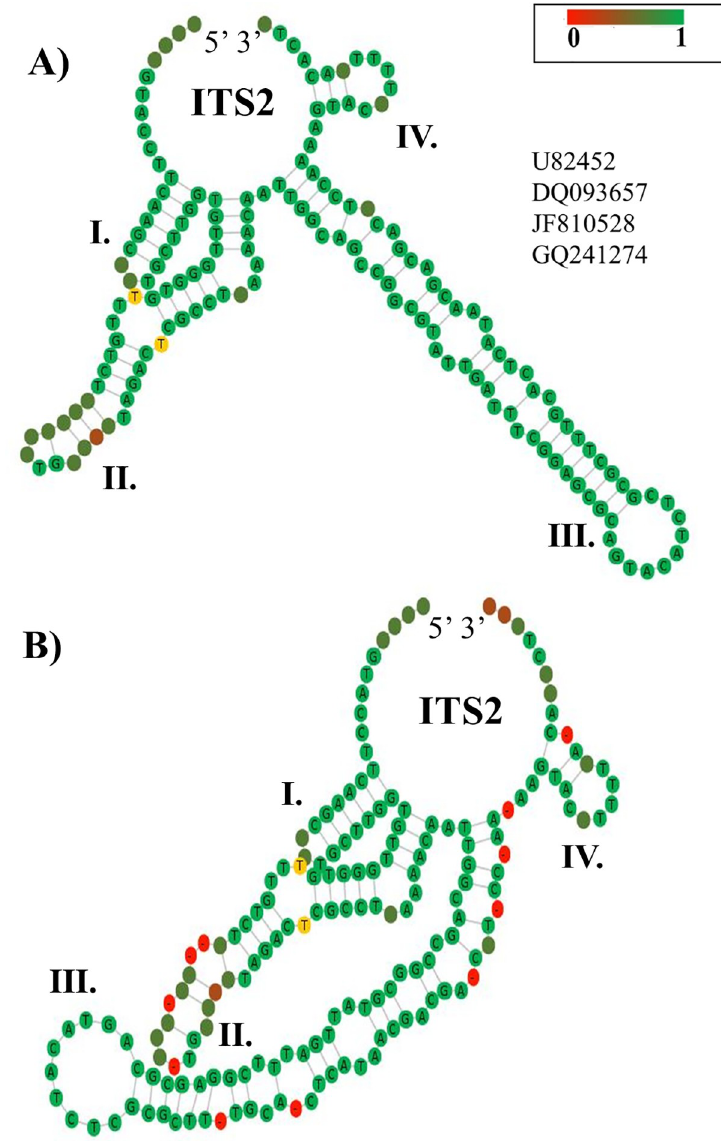
Fig 11. Four major consensus ITS2 S2s from Ampelomyces are represented in three main clades. (A) Consensus ITS2 S2 of Models 2 and 3, which are grouped in clade 1a. (B) Consensus ITS2 S2 belonging to clade 1b are represented by Model 6. (C) Consensus ITS2 S2 of Models 4 and 5 that belong to clade 2. (D) Consensus ITS2 S2 of Models 1 and 7 that belong to clade 3. All consensus ITS2 S2s have gaps and were obtained with the 4SALE v1.7.1 software. Yellow nucleotides indicate conserved motifs (U-U mismatch and AAA motifs) known to be found in yeasts and vertebrates [73]. UGG, UGGU and GGUU motifs on helix III are indicated with black circles. The bar on the upper right side indicates the level of nucleotide conservation, with the most conserved nucleotides in green. The gaps are depicted in red. The GenBank IDs used to build each consensus are indicated below each